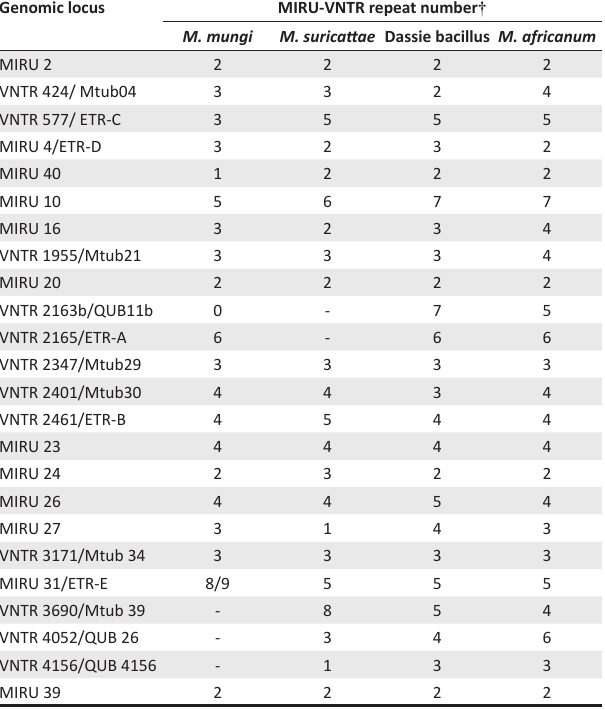
FIGURE 3: Spoligotype patterns of members of the Mycobacterium tuberculosis complex (MTC) occurring in the southern African subregion and representative patterns of other Mycobacterium tuberculosis complex species. TABLE 1: Representative Mycobacterial Interspersed Repetitive Units – Variable Number of Tandem Repeats patterns for the dassie bacillus, Mycobacterium mungi, Mycobacterium suricattae and Mycobacterium africanum